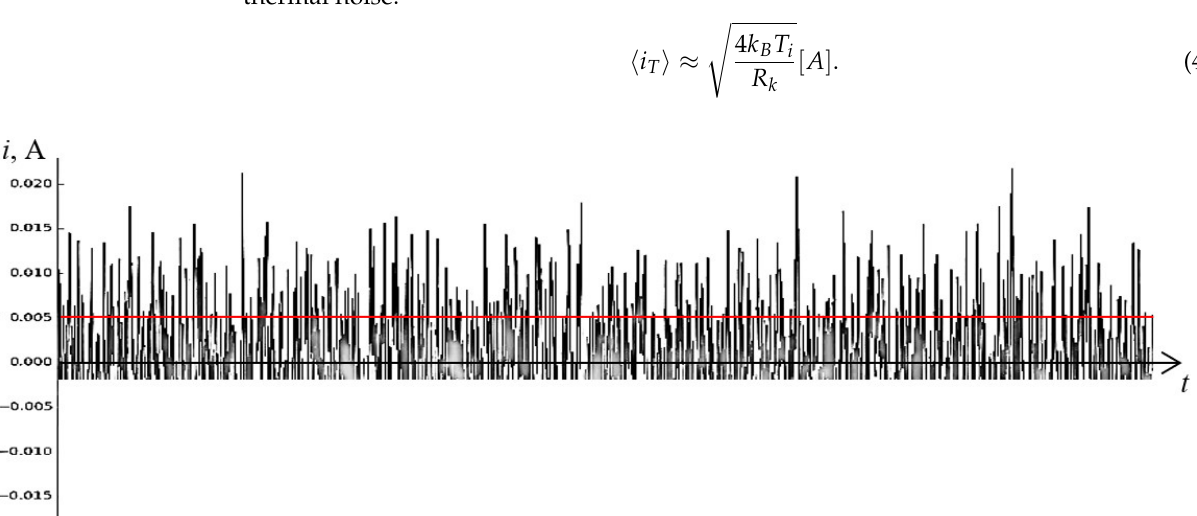
Figure 6. Expected thermal noise in a semiconductor ring.